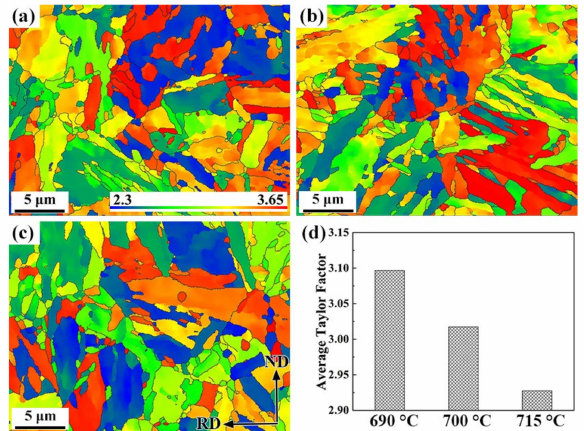
Figure 10. Taylor factor maps of the 0.5Cr0.4W steels tempered at ( a ) 690 ◦ C, ( b ) 700 ◦ C, ( c ) 715 ◦ C, and ( d ) average Taylor